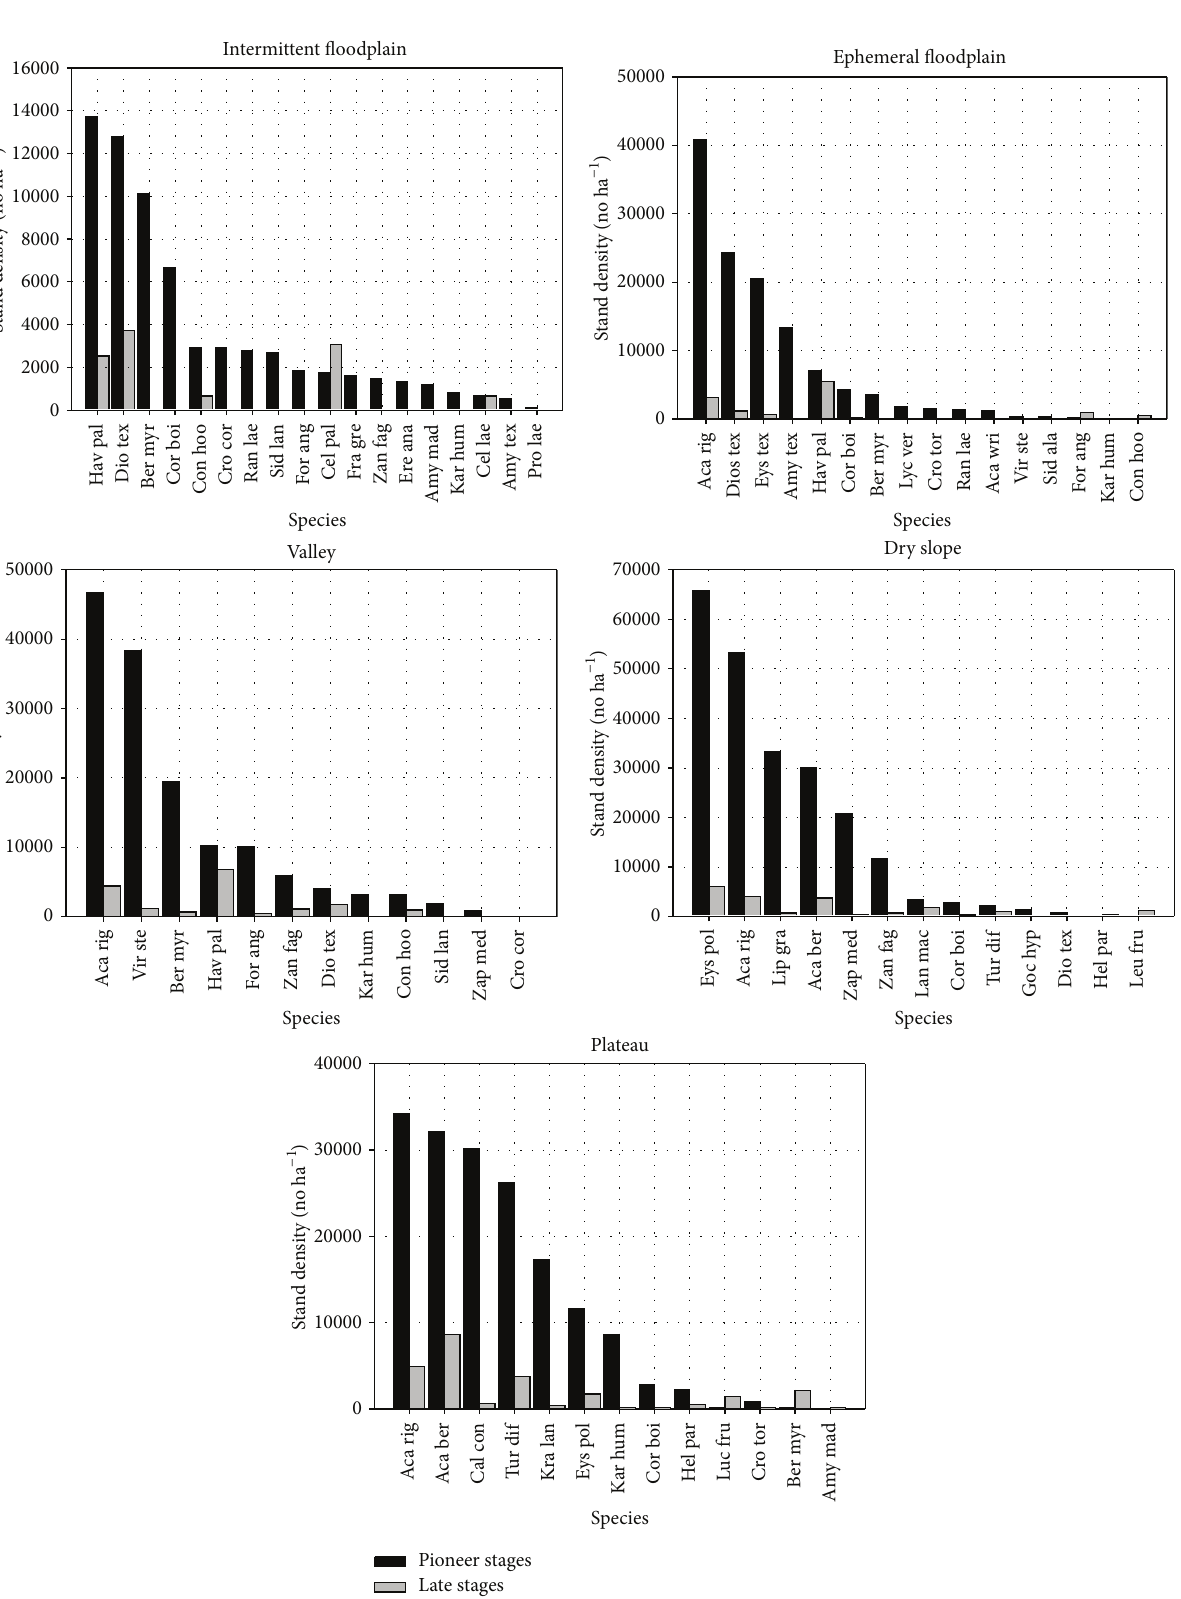
Figure 1: Diversity-abundance of species in pioneer and late succession stages in the Tamaulipan thornscrub in northeast